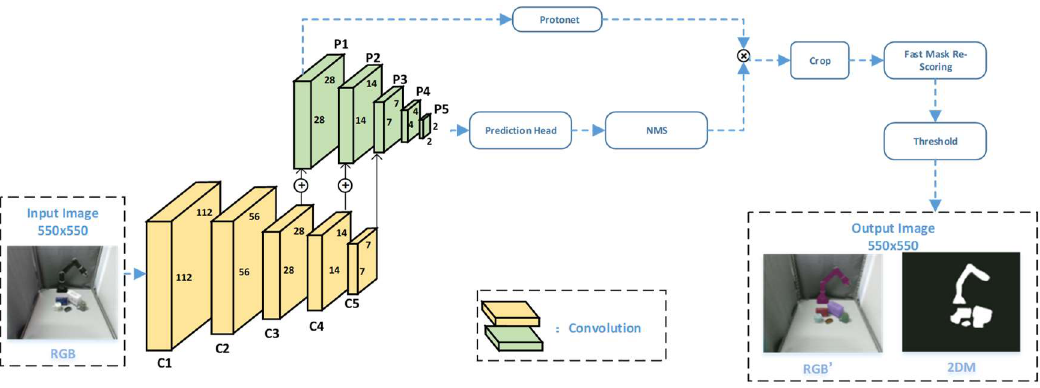
Figure 2. The network structure of YOLACT++.